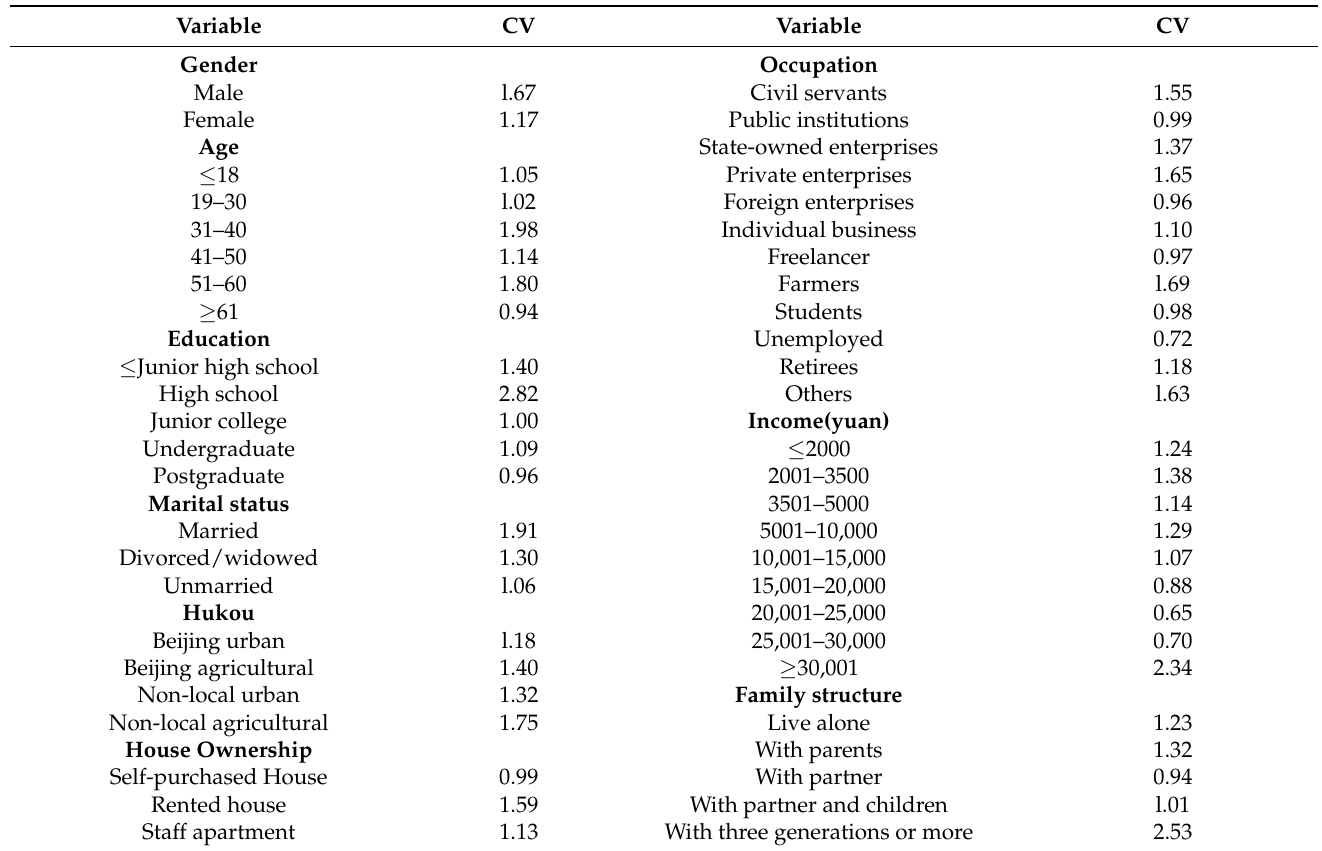
Table 8. Coefficient of variation of residents in all social